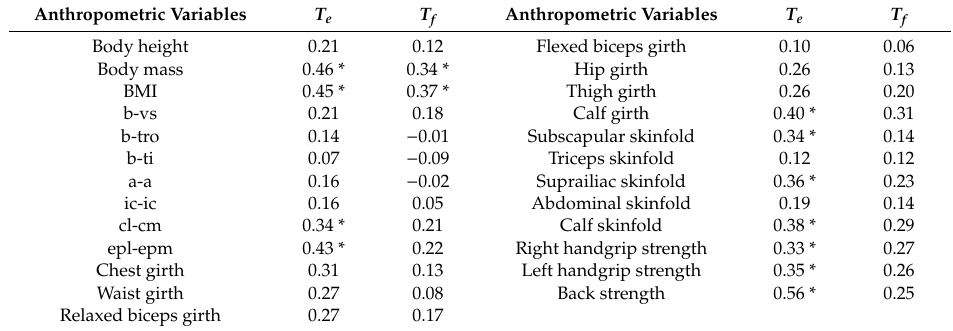
Table 3. The correlation coe ffi cients between the muscle torque of extensors ( T e ) and flexors ( T f ) of the knee joint and anthropometric variables for the entire group of soccer players ( n = 37).